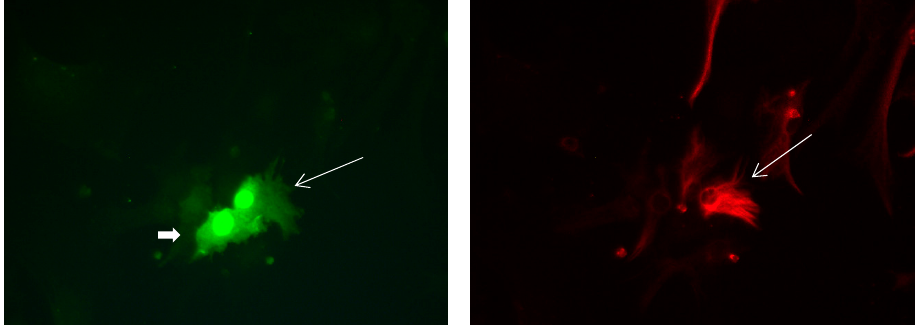
Figure 12. Cultures in a serum-free medium, 3 days (4 days after the passage): Immunofluorescence with anti-GFAP (glial fibrillary acidic protein) (red, secondary antibody: donkey anti-goat IgG Alexa Fluor 594), and with anti-Calbindin D28k (polyclonal antibody from the company SWANT) (green, secondary antibody: donkey anti-rabbit IgG Alexa Fluor 488). Epifluorescence microscopy. One Calbindin D28k positive and GFAP-positive astrocyte (long arrows), besides 1 Calbindin D28k positive and GFAP-negative astrocyte (short arrows).